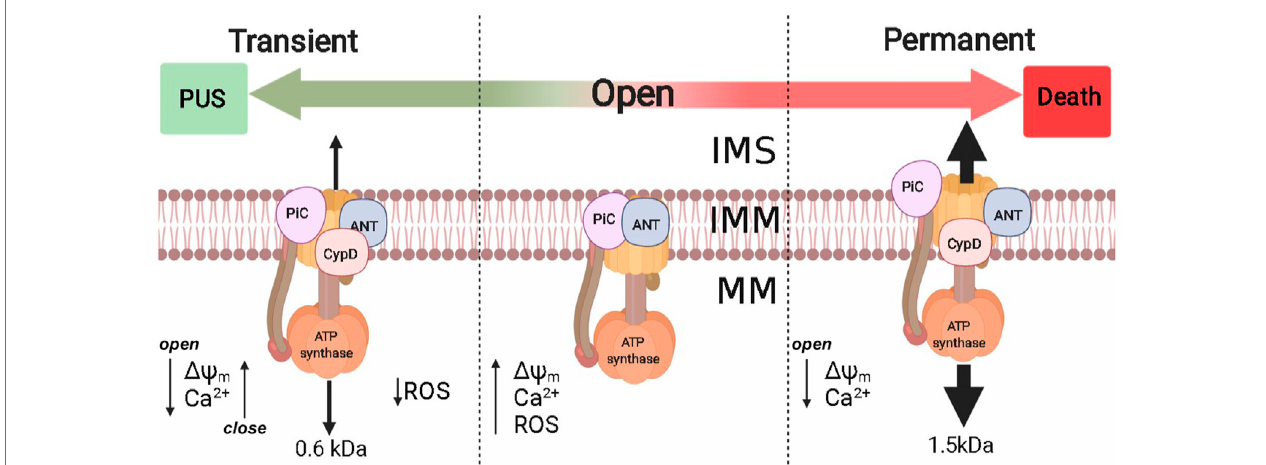
FIGURE 4 | Permeability transition pore and their implications in PUS. Extrinsic PUS mechanisms were developed in eukaryotes and are present from yeast to mammals, probably tocontrolintramitochondrial [Ca 2+ ] and ROS production. The molecular identity ofPTP isstill under debate, although at least Complex V,PiC, ANT, and CypDhavebeen proposed. PTPprobably hastwoopening modes: 1)Transient, wherePTPispermeabletomoleculesupto600 Daand reversiblydecreases ΔΨ m [Ca 2+ ] m, decreasing ROS production; 2) Permanent that allows molecules up to 1.5 kDa and metabolite ef fl ux. Nonreversibility may lead to cell death. ΔΨ m: mitochondrial transmembrane potential; [Ca 2+ ] m , mitochondrial Ca 2+ ; IMS, intermembrane space; IMM, inner mitochondrial membrane; MM, mitochondrial